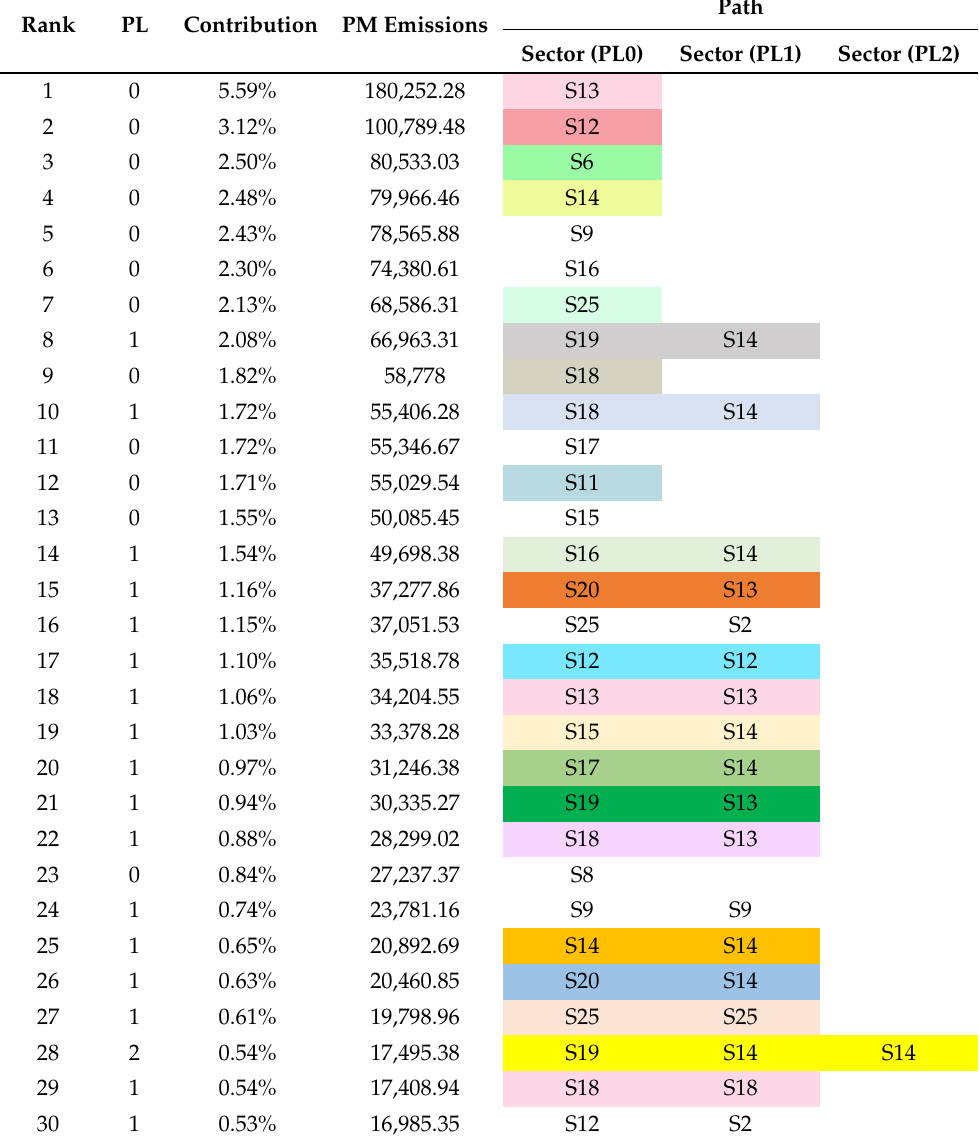
Table 6. The top 30 paths for China’s PM emissions start with the final demand category and end up in a